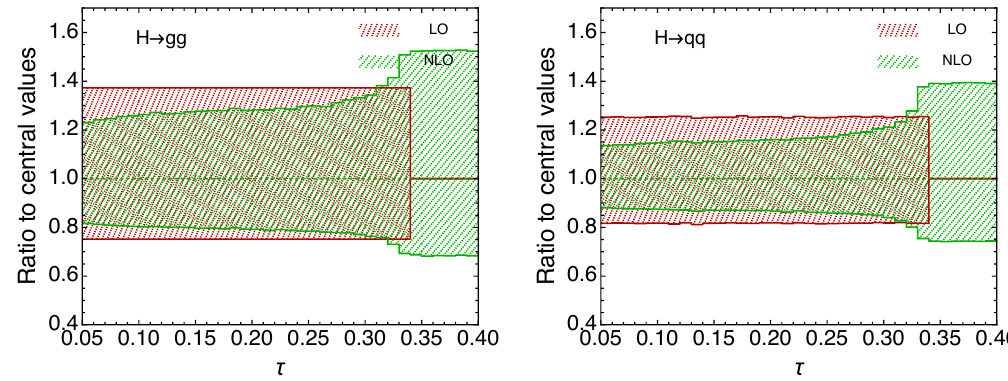
Figure 5 . The ratios of the LO and NLO di(cid:11)erential cross sections to their central values. pronounced for larger (cid:28) . We also (cid:12)nd that the scale uncertainties of the LO results do not overlap with the NLO ones. This indicates that the scale variation of the LO di(cid:11)erential cross sections underestimate the theoretical uncertainties. We also show in (cid:12)gure 5 di(cid:11)er- ential cross sections normalized to their central values. At LO the scale variations